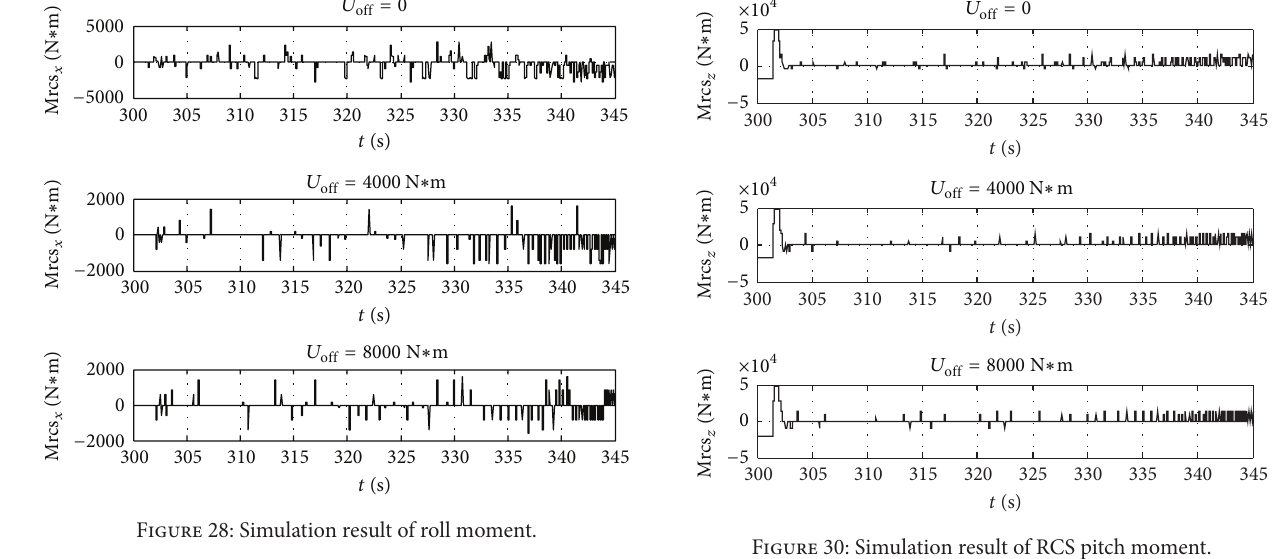
Figure 30: Simulation result of RCS pitch moment.